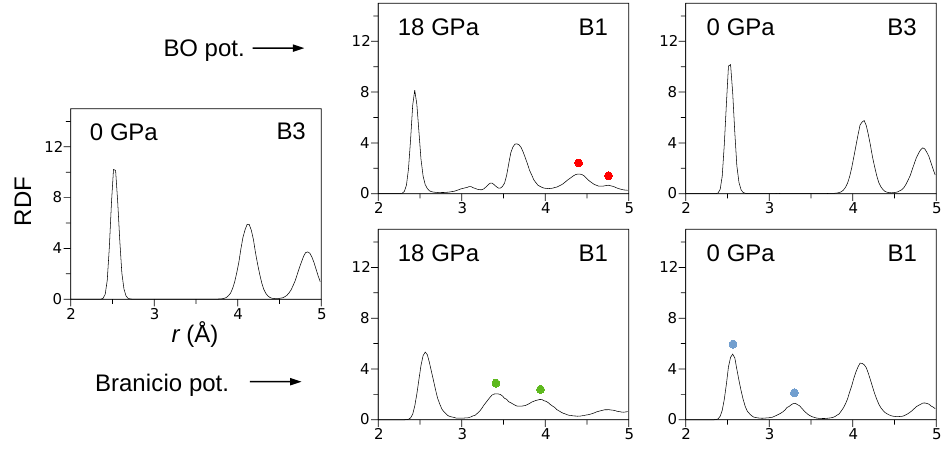
Figure 4. The radial distribution functions calculated B3 ↔ B1 phase transformations. The presented data reveal the complete structural reversibility of the phase transformation modeled by the BO